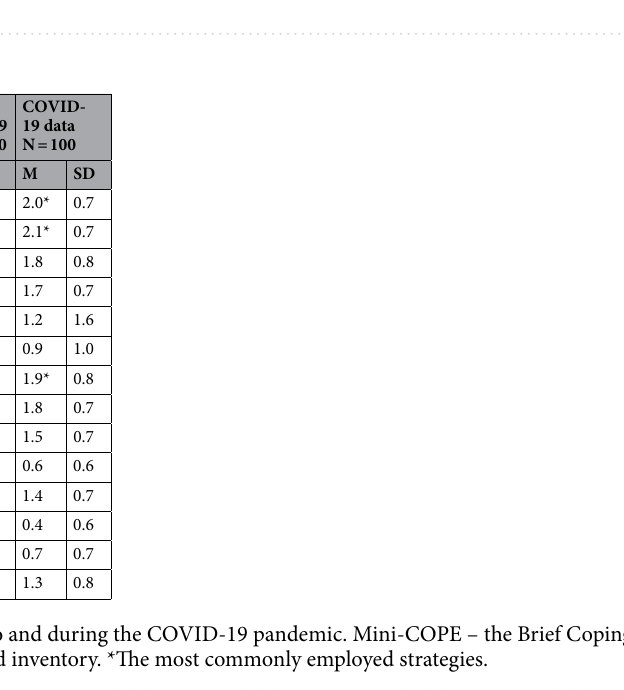
Table 5. The SWAQ results prior to and during the COVID-19 pandemic (independent samples Student’s t -test). SWAQ the Subjective work assessment questionnaire. *Highly stress-inducing factors. **Statistically significant values p < 0.05.